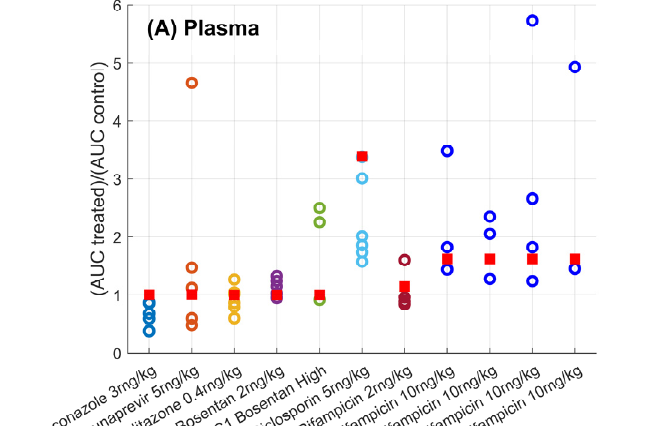
Figure 6. Predicted versus observed Δ R 1 -time profiles for different sites (D, E, G1, and G2) and perpetrators (asunaprevir, bosentan, ciclosporin, ketoconazole, pioglitazone, and rifampicin) in plasma (Panel A ) and liver (Panel B ). Predictions using the gadoxetate physiologically-based pharmacokinetic model considered inhibition of both 𝐶𝐿 (cid:3048)(cid:3043)(cid:3047)(cid:3028)(cid:3038)(cid:3032) and 𝐶𝐿 (cid:3029)(cid:3036)(cid:3039)(cid:3036)(cid:3028)(cid:3045)(cid:3052) , assuming unbound plasma concentrations to drive inhibition of each transporter parameter. Doses for each drug are listed in Table 1; “Bosentan High” refers to the 4–6 mg/kg doses of bosentan. The PBPK model predicted well the gadoxetate 𝛥𝑅 (cid:2869) plasma profiles in the control phase (Figure 6A). The between-site variability was limited and therefore the mean profile simulated with the PBPK model was sufficient to capture the systemic gadoxetate phar- macokinetics. When gadoxetate was co-administered with ciclosporin and rifampicin, the inhibition of gadoxetate liver uptake clearance was accompanied by an increase in 𝛥𝑅 (cid:2869) in the terminal phase of the plasma profile, which was predicted successfully by the PBPK model (Figure 6A). The PBPK model coupled with the perpetrators compartmental mod- els, predicted reasonably well the change in gadoxetate plasma AUC for ciclosporin, and lack of change in AUC for asunaprevir, pioglitazone, and bosentan. This approach also captured the effect of rifampicin as a function of the dose: for a 2 mg/kg dose the model correctly predicted a lack of interaction ( 𝐴𝑈𝐶𝑅 < 1.25 ) and increase in the DDI at 10 mg/kg, although the magnitude was under-predicted (predicted 𝐴𝑈𝐶𝑅 = 1.62 vs. 1.89; average of four studies, Table 4).